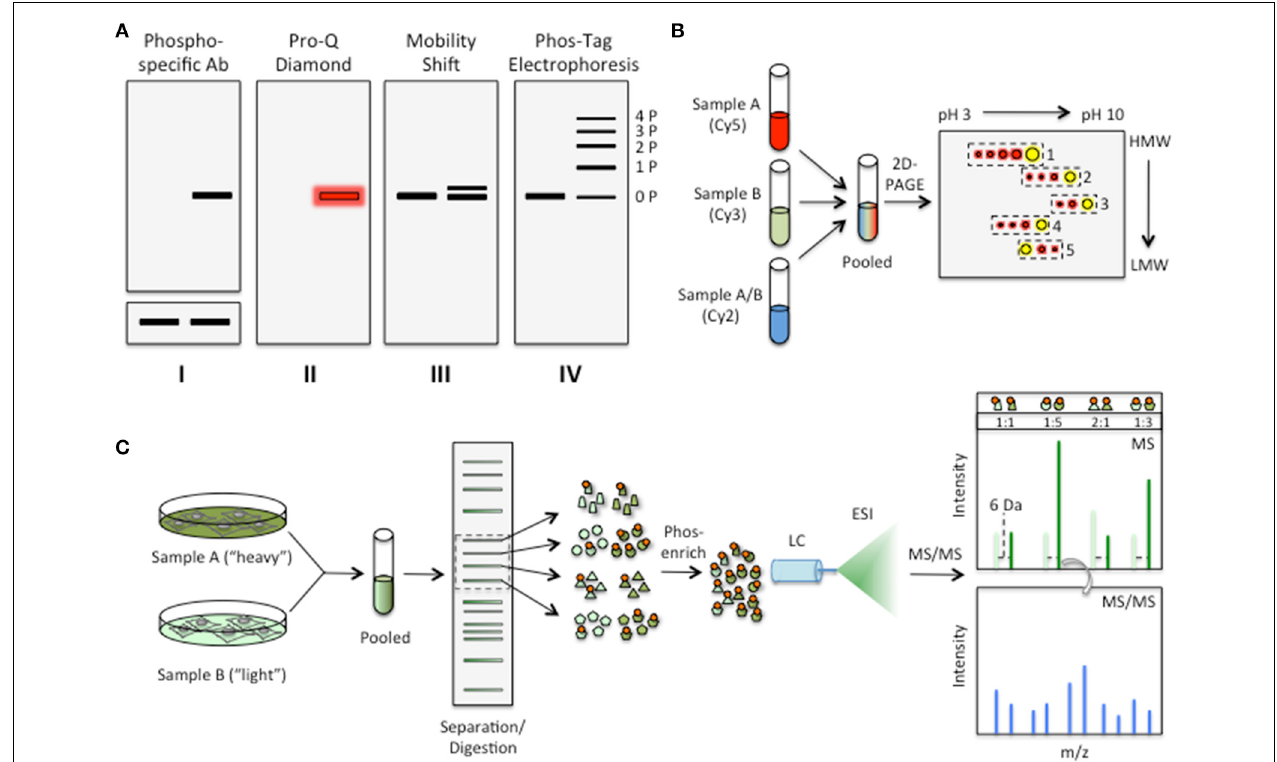
FIGURE 2 | “Top-down” approaches to assess changes in the phosphorylation status of cellular proteins. (A) Approaches based on 1D PAGE. I Western blot analysis using an antibody that specifically recognizes a particular phosphosite. To account for phosphorylation-dependent